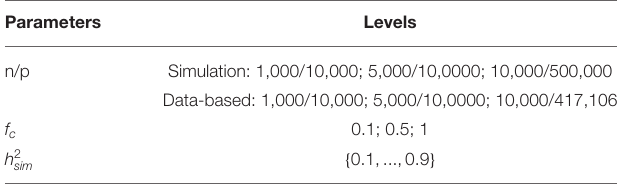
TABLE 1 | Table of the parameters sets of the simulations.